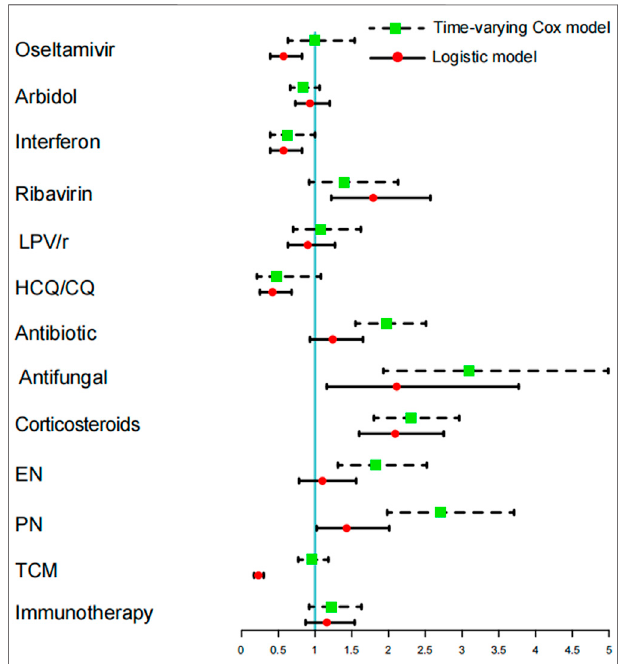
FIGURE 2 | Comparing the time-varying Cox model and logistic regression model to study the different risks of acute liver injury between hospitalized medication and COVID-19